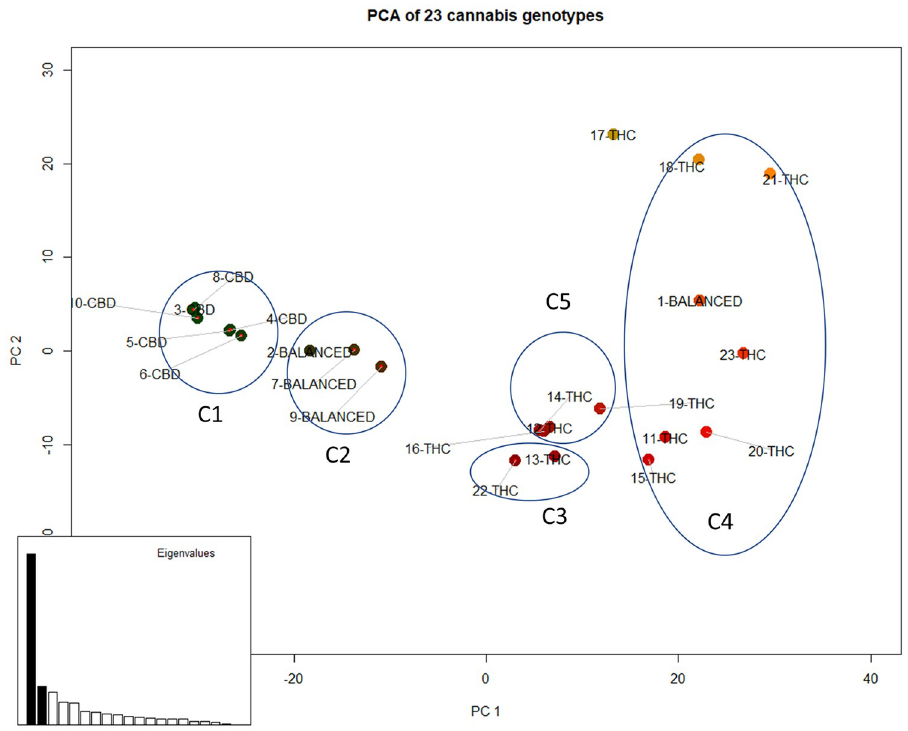
Fig 3. Scatter plot of 23 cannabis strains on PC1 & PC2 using 344 structural SNPs. Clusters indicated as C1, C2, C3, C4 and C5 correspond to I-SNPs in Table 1.